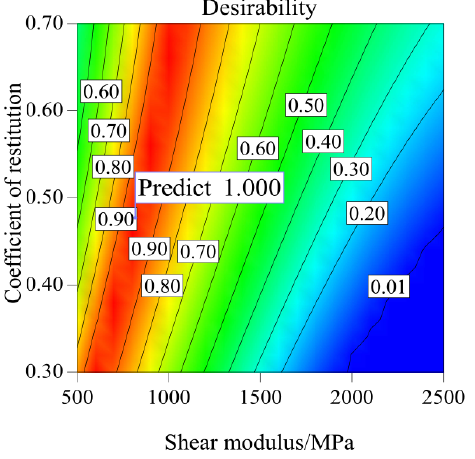
Figure 5. Desirability contour map velocity as indicator.